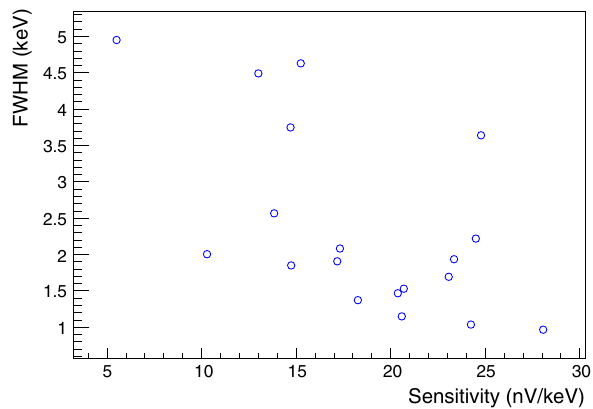
Fig. 12 Sensitivity versus baseline resolution (FWHM) for the 19 LMO detectors considered in this analysis. One detector (LMO 2) is omitted due to abnormal performance; see text